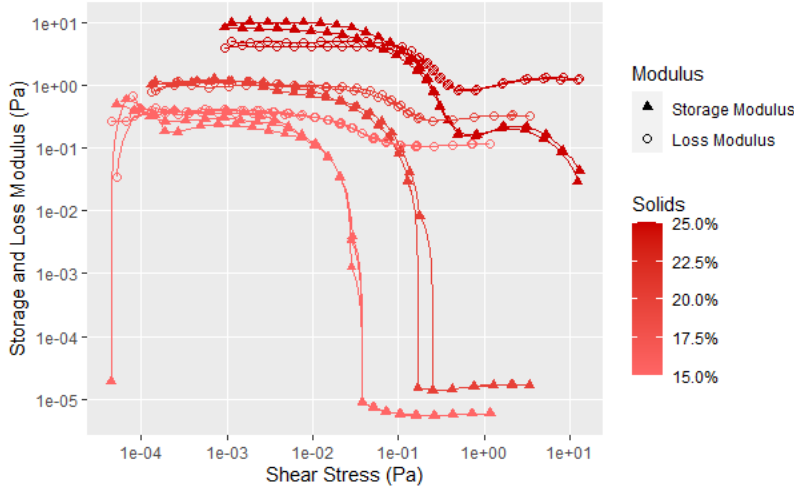
Figure A10. All replicates for samples shown in Figure 11.